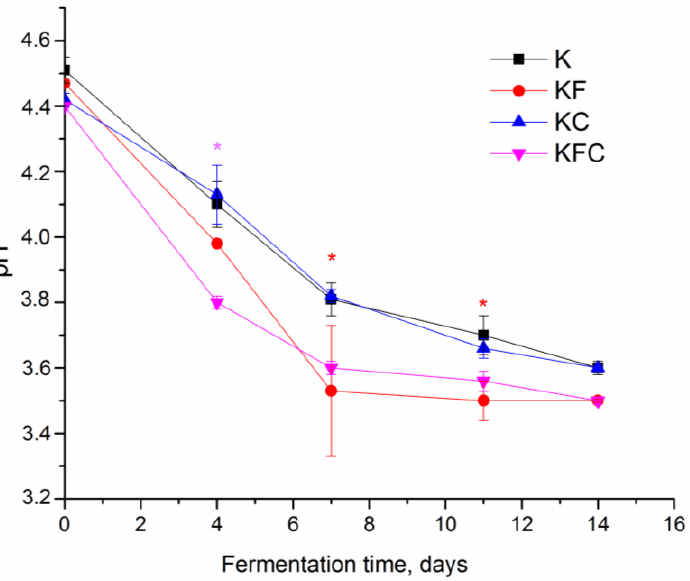
Figure 1. Changes in pH during kombucha fermentation (K—control, KF—kombucha with algae extract, KC—kombucha with lichen extract, KFC—kombucha with a mixture of algae and lichen extracts). * Significantly different from K, p < 0.05.